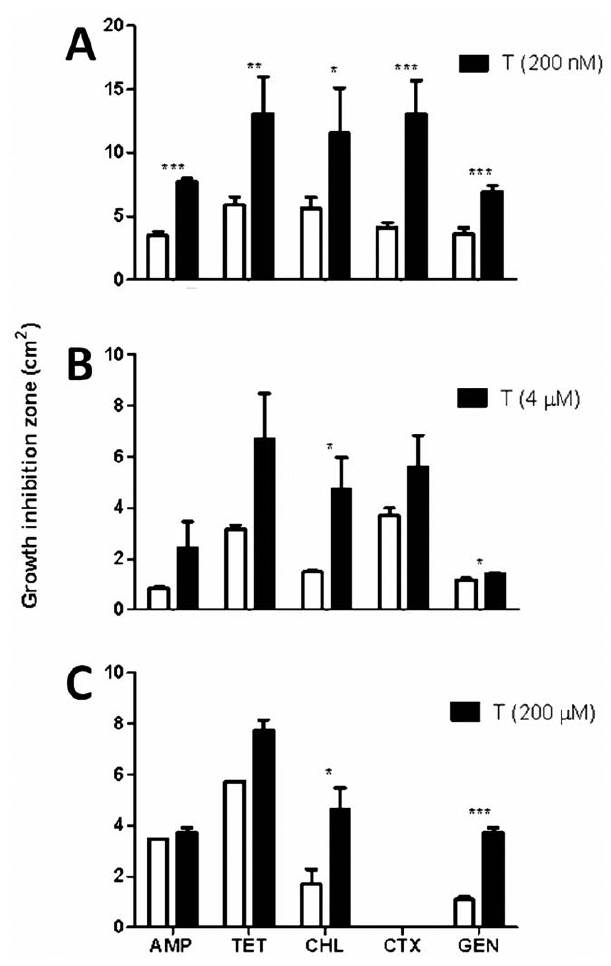
Figure 1. Tellurite-mediated antibiotic-potentiating effect in different bacteria. Antibiotic-mediated inhibition growth zones were determined for E. coli (A), P. aeruginosa (B) and S. aureus (C) grown in the absence (white bars) or presence of the indicated tellurite (T) concentrations as described in Methods. Values represent the average of at least 4 independent trials and significance was determined using t- test analysis (p , 0.05). Significance values are (*) p , 0.05, (**) p , 0.01 and (***) p ,